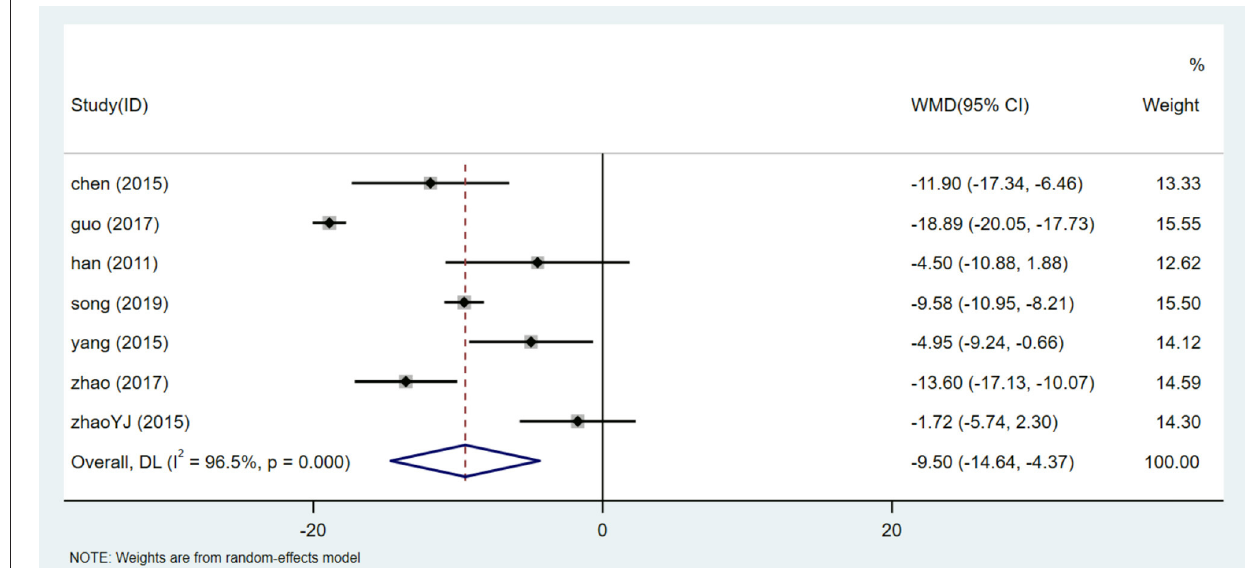
FIGURE 9 | Forest plot of SBP.